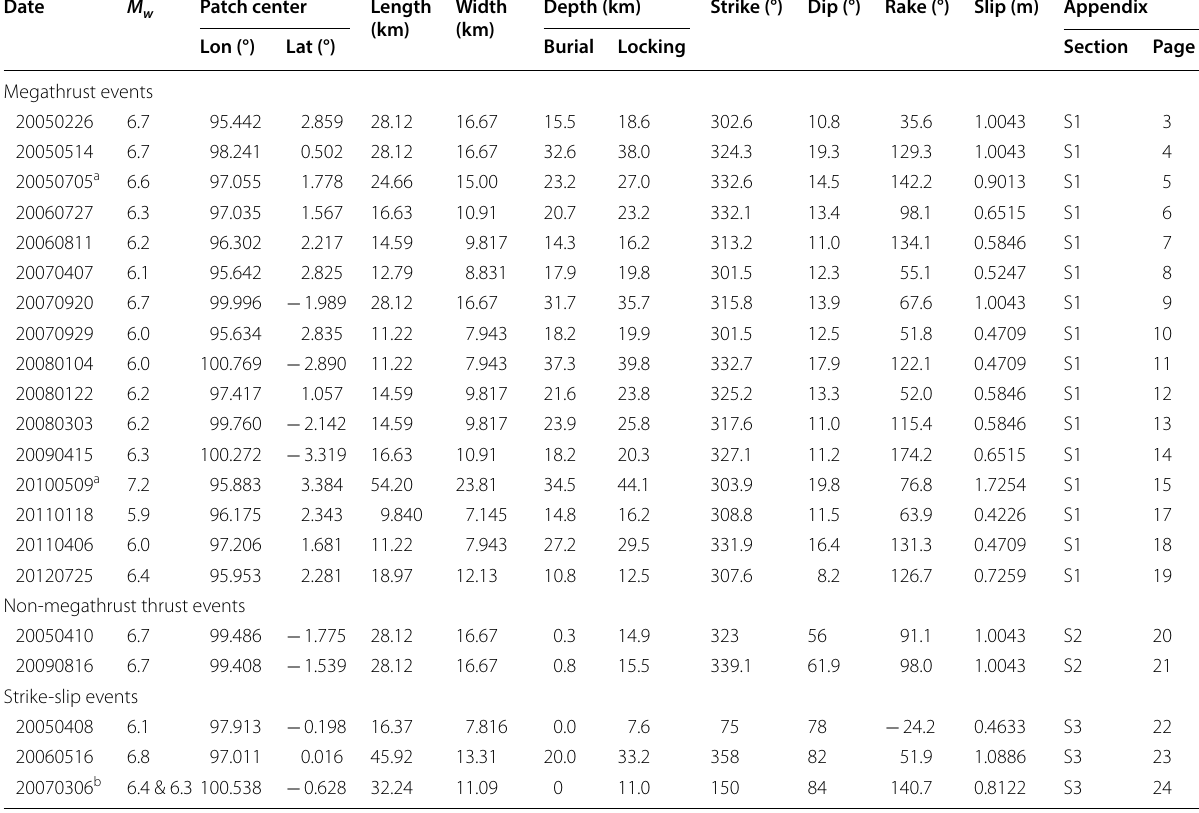
Table 1 Summary of the preferred model for all events modeled in this study